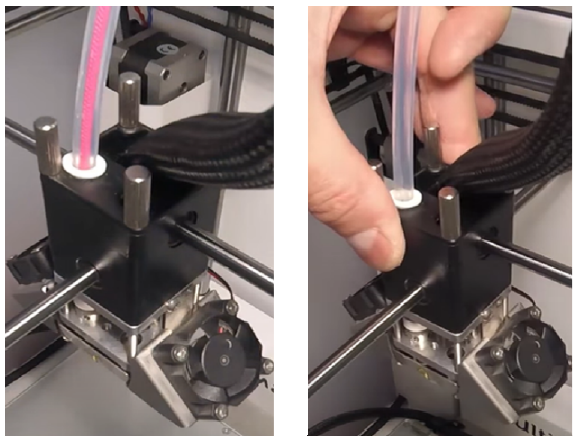
Figure 5. Changing of the clogged nozzle The question that can be posed is: How to clean the nozzle without stopping the